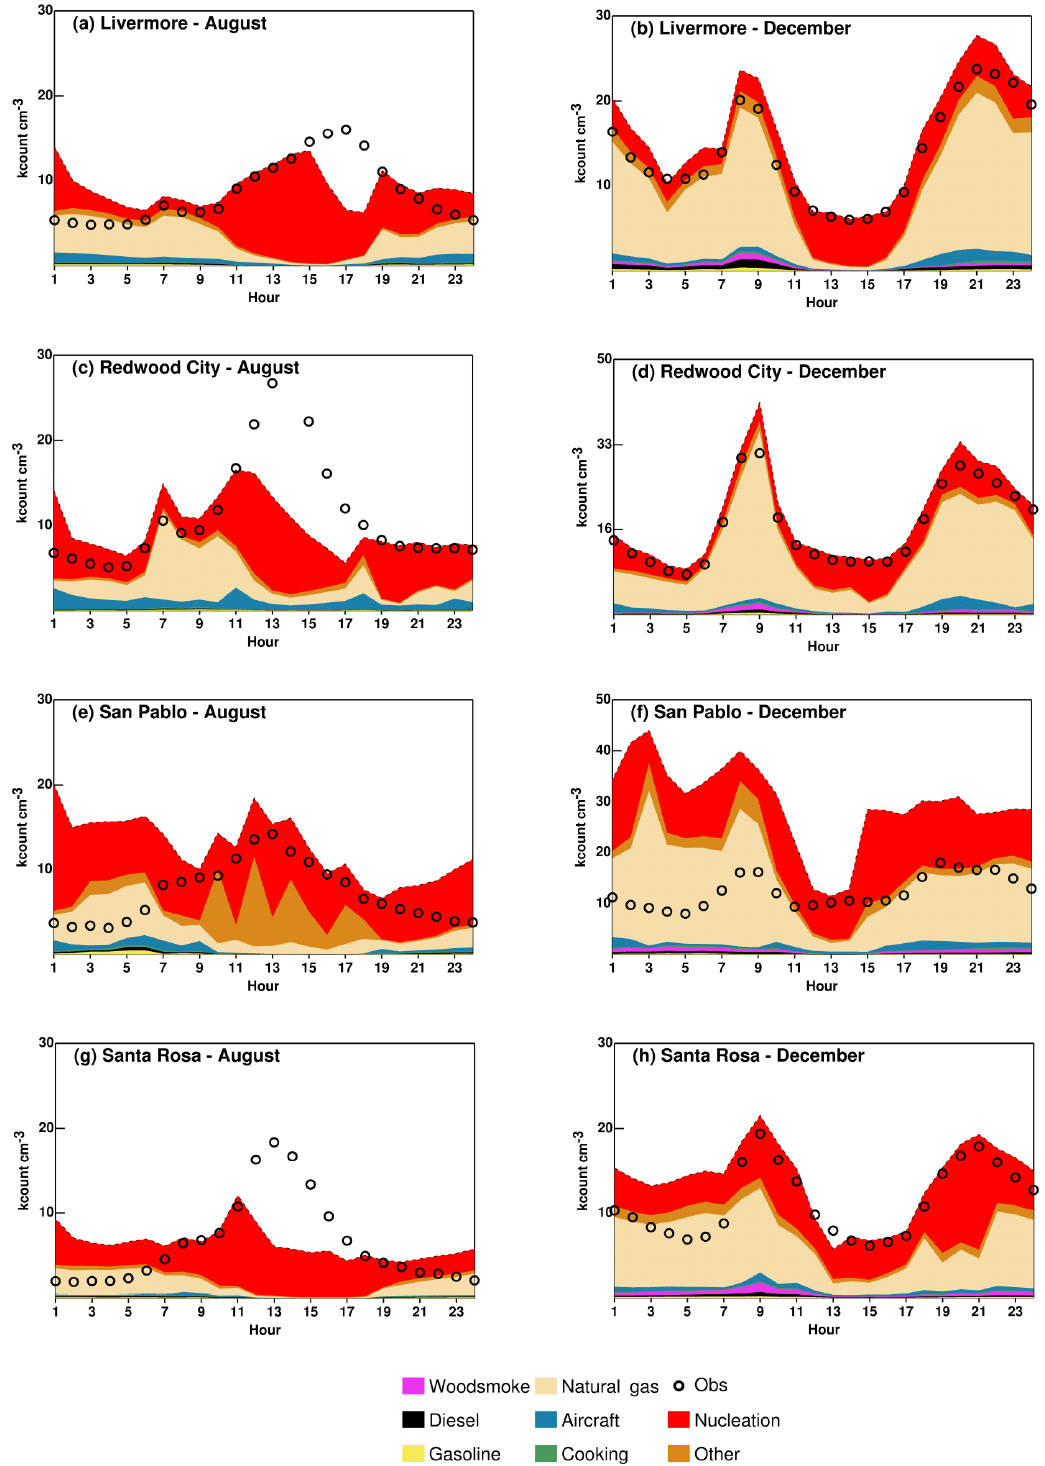
Figure 15. Diurnal variations of measured N 7 and predicted best-fit N 10 averaged for August 2012 (a, c, e, g) and December 2012 (b, d, f, h) at Livermore, Redwood City, San Pablo, and Santa